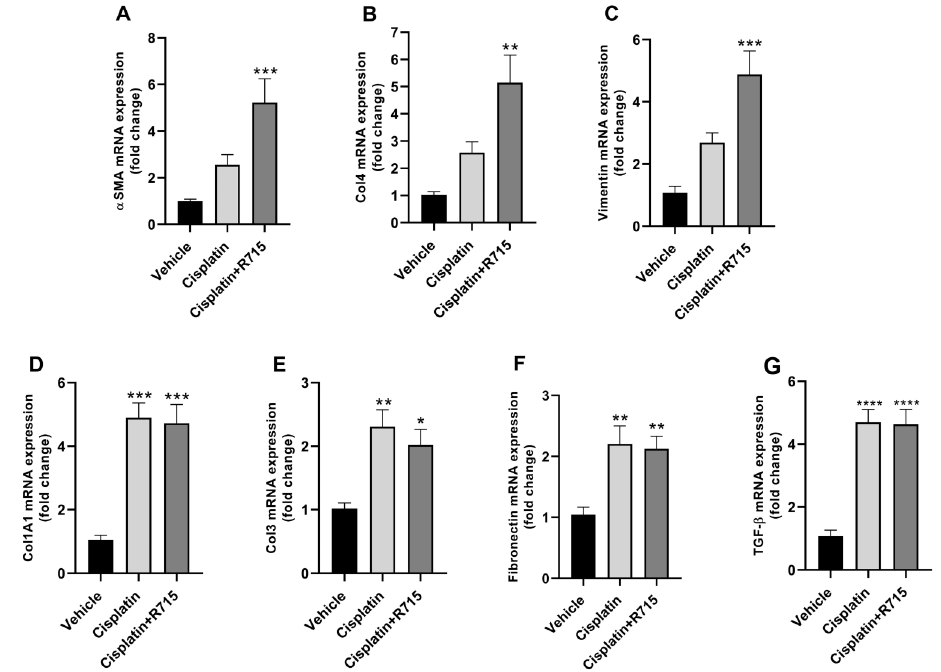
Figure 6. Multiple cisplatin treatment increases renal fi brosis markers. Kidney mRNA levels of a -SMA ( A ), collagen 4 ( B ), vimentin ( C ), collagen 1A1 ( D ), collagen 3 ( E ), fi bronectin ( F ), and TGF- b ( G ). Data are reported as means ± SE (n=6 per group). *P o 0.05, **P o 0.01,